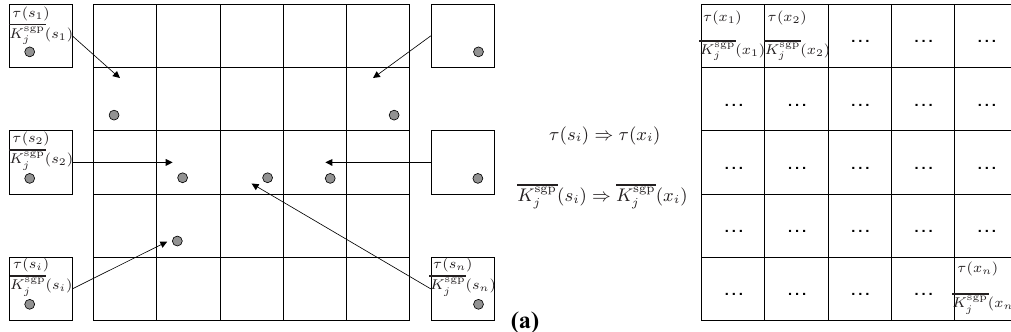
Figure 2. Sketch of the method used to compute the grid-average plume reaction rates K sgp ensemble of small-scale plume simulations s 1 , s 2 ,..., s n is run by changing the local background conditions that are representative of the CTM grid-cells. The resulting small-scale concentrations c p are used to get τ and K sgp while using Equations (29) or (42) for each s i ; ( b ) the plume reaction j k rates K sgp are then reconstructed at each grid-point x i of the CTM by interpolating/best-fitting the j pre-computed rates by means of Equations (34) and (35). The procedure is exactly the same for the subgrid-scale reaction rates K sgs and K eff j j